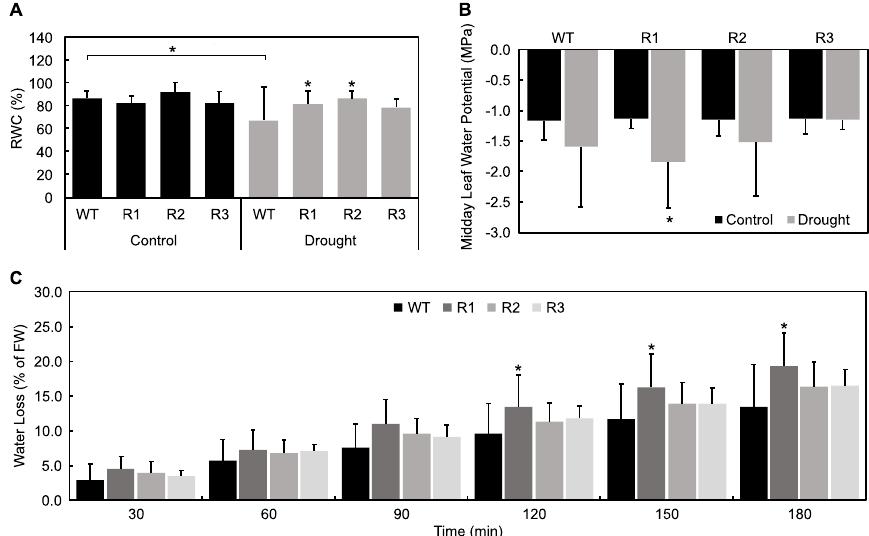
Figure 6. Effect of drought on plant water status in WT and SPL9 -RNAi plants: ( A ) relative water content (RWC) of 10 leaves harvested from plants under both conditions. The asterisks indicate significant differences within treatments (Dunnett’s test), and the bars indicate significant differences between treatments (Sidak test) in a two-way ANOVA where p < 0.05 and n = 10. ( B ) Leaf water potential of plants measured around midday: the asterisks indicate significant differences between treatments ( p < 0.05, where n = 9, 10, two-way ANOVA, Sidak test). ( C ) Water loss assay performed by weighing aboveground tissue every half hour for 3 h after decapitating plants that were exposed to drought: the asterisks indicate significant differences from WT within the time point ( p < 0.05, where n = 10, two-way ANOVA and Dunnett’s test). 2.4. Effect of Drought on the Antioxidant-Mediated ROS Scavenging Capabilities of SPL9-RNAi Alfalfa The transcript abundance of the antioxidant-related genes Catalase 1 ( CAT 1) and Glutathione Synthase ( GSH ) was examined to determine whether MsSPL9 serves to maintain the levels of these enzymes in alfalfa exposed to drought. WT alfalfa had increased abundance of CAT1 under drought compared to control plants, but CAT1 abundance did not change between treatments in SPL9 -RNAi plants (Figure 7A). In fact, R2 had higher CAT1 abundance than WT under control conditions. Similar maintenance of GSH transcript levels was also detected between drought and control treatments in SPL9 -RNAi plants (Figure 7B). GSH abundance decreased in WT plants in response to drought, but R3 had increased GSH abundance under drought conditions compared to WT. Figure 7. Impact of MsSPL9 on antioxidant activity in leaves of alfalfa WT and SPL9 -RNAi: ( A ) transcript levels of Catalase 1 (CAT1) leaves. ( B ) Transcript levels of Glutathione Synthase (GSH): the asterisks indicate significant differences within treatments (Dunnett’s test), and the bars indicate significant differences between treatments (Sidak test) in a two-way ANOVA where p < 0.05 and n = 8–10.